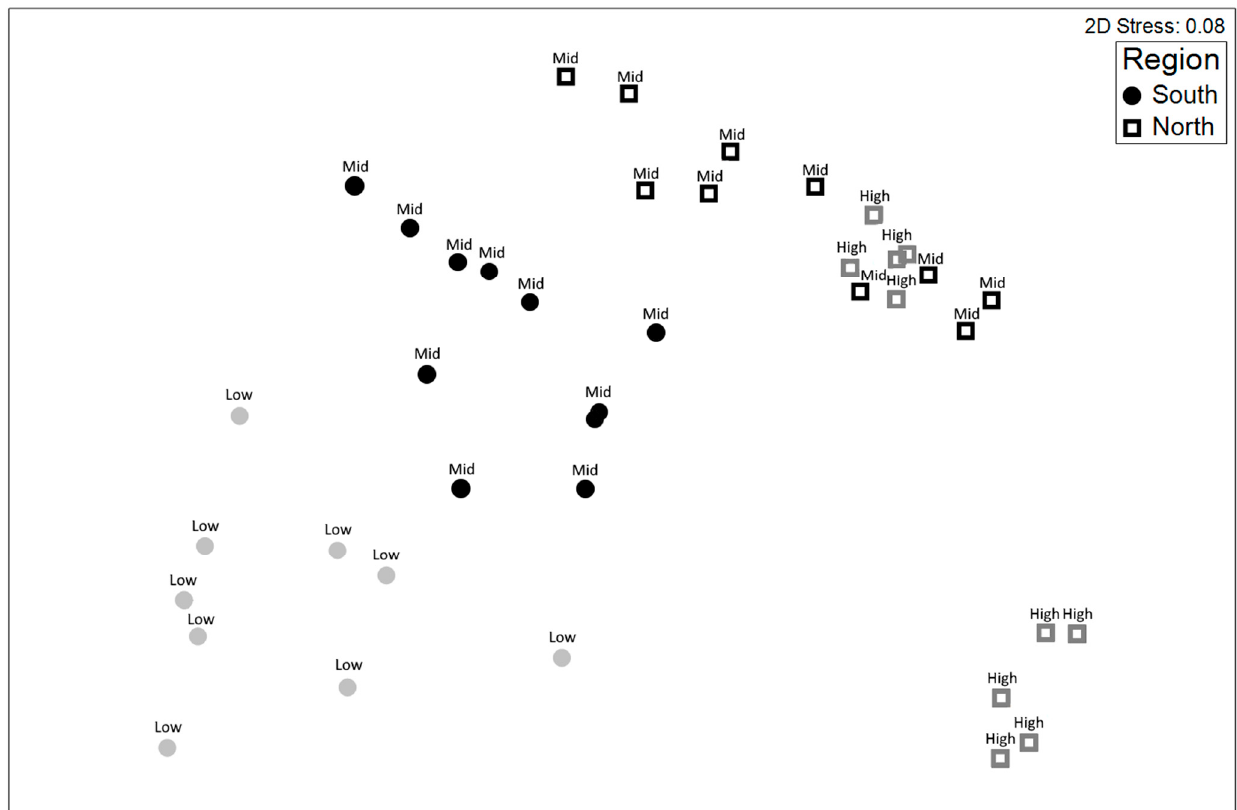
Figure 5. Multidimensional scaling plot (where the x and y axes represent coordinates of dissimilarity between samples) of variation in percentage cover of several key habitat types at sites recovering from varying degrees of uplift (high [2.0–6 m], mid [1–2.0 m] and low [<1 m]). Increasing distance from one point to another signifies increasing dissimilarity in the coverage and composition of habitat types within samples (where samples are an area of 100 m 2 ). Locations are separated into two distinct biogeographic regions, “North” and “South” and all the imagery was captured in February and March 2019. Northern sites had no examples of uplift in the low category, while southern sites had no examples of high uplift.